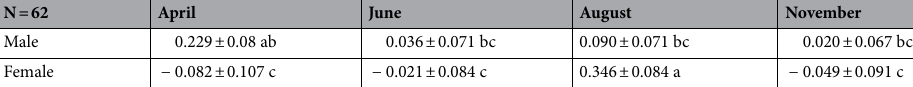
Table 8. Significant ( P < 0.041) Sex × Season interaction in eSCD1 expression level. Means followed by different letters are significantly different by Tukey’s HSD.